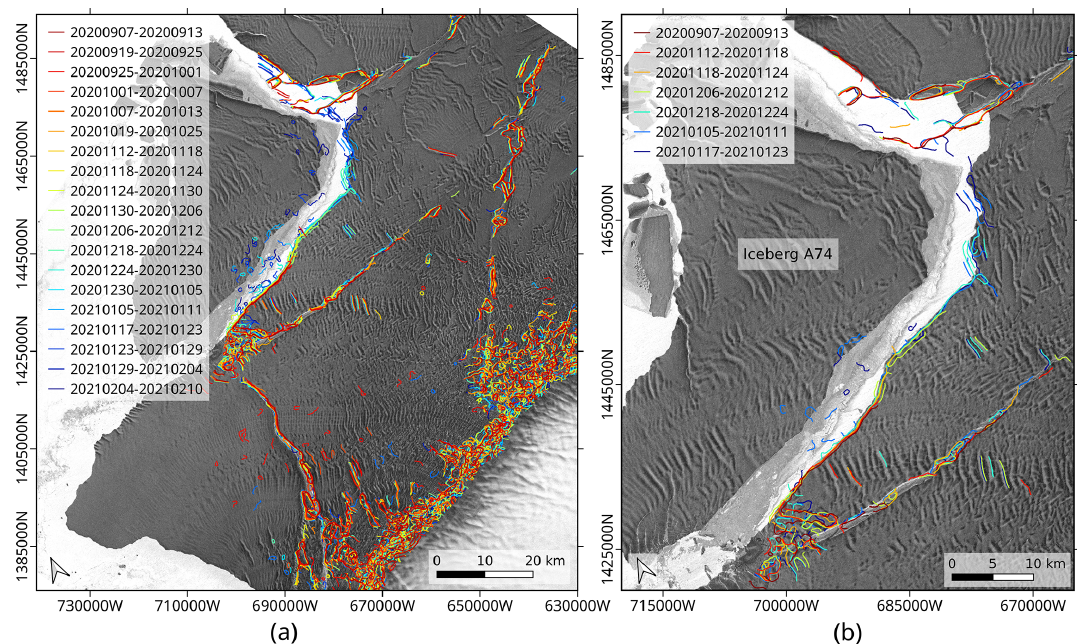
Figure 9. (a) Evolution of BIS rifting system between 7 September 2020 and 23 January 2021 from automatically delineated cracks. (b) Prop- agation history of the North Rift with selection of significant dates. The delineated cracks are overlaid on a Sentinel-1 brightness image acquired on 6 March 2021, showing the calving front shape after the iceberg A74 formed.